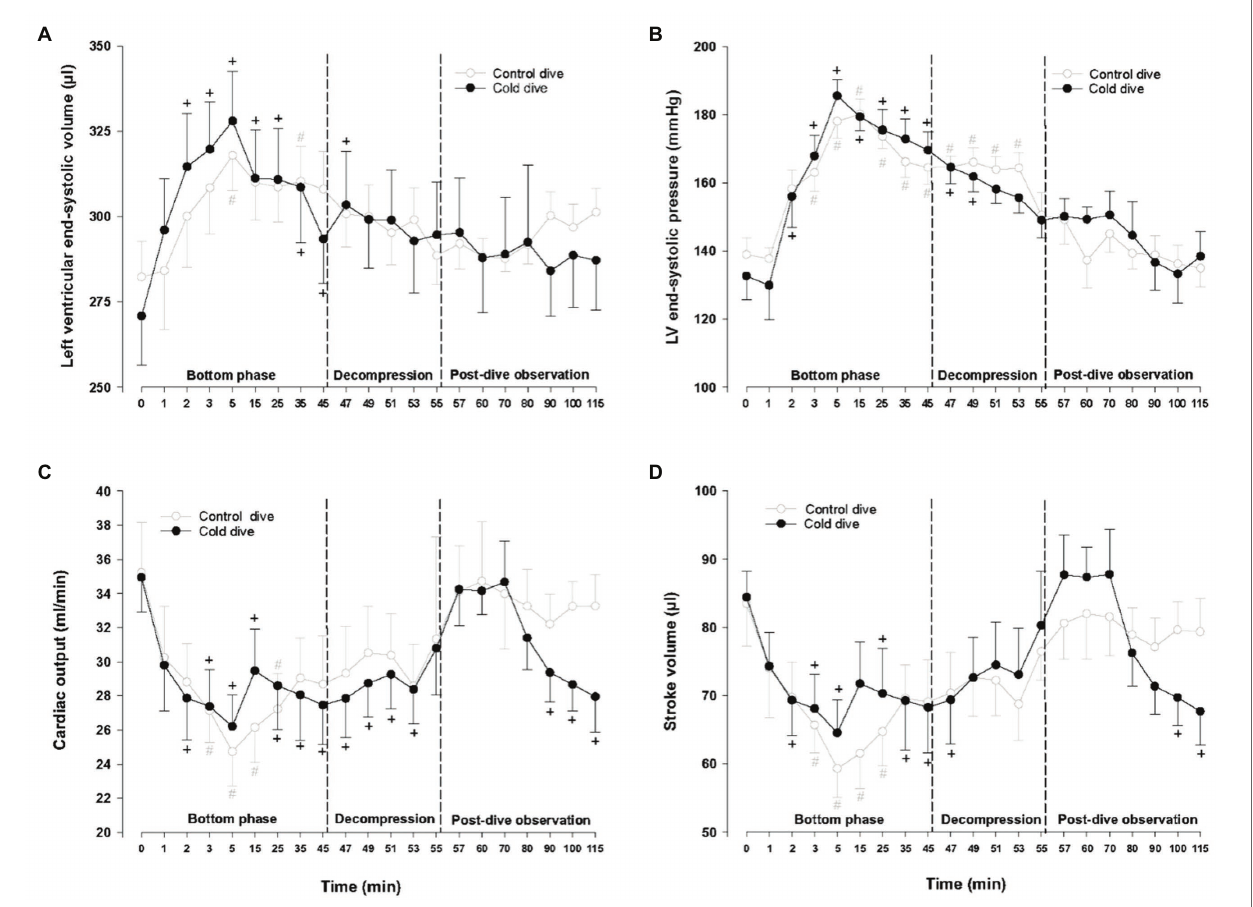
FIGURE 2 | Hemodynamic variables. (A) Left ventricular end-systolic volume (LVESV), (B) left ventricular end-systolic pressure (LVESP), (C) cardiac output (CO), and (D) stroke volume (SV). Data are mean ± SEM. N = 9 in both groups. + p < 0.05 compared to baseline in the cold dive group. # p < 0.05 compared to baseline in the control dive group. Data for the control dive group are adapted from Gaustad et al.